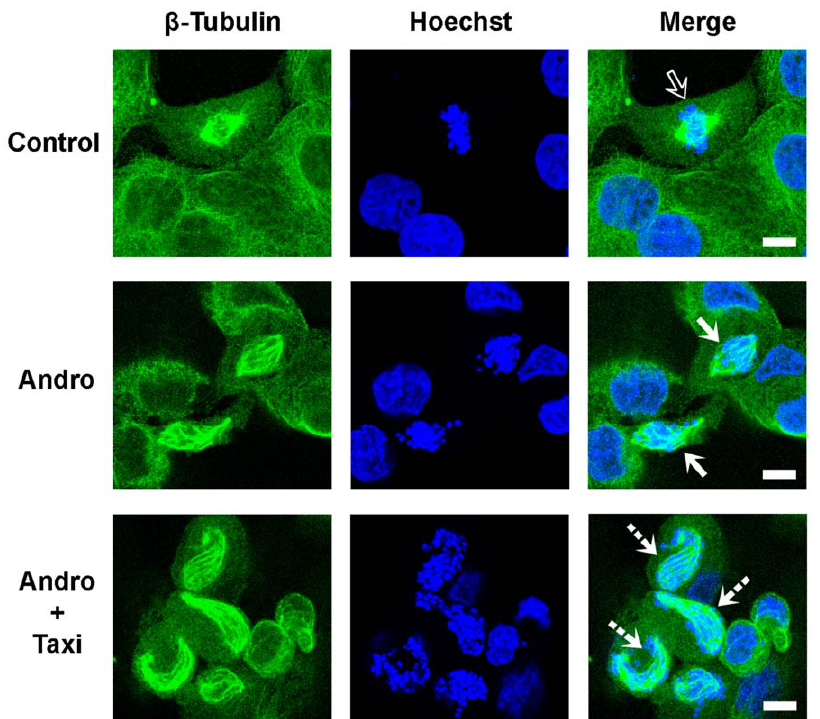
Figure 9. Immunofluorescence microscopic images of treating DU145 cells with Andro and Taxi on the spindle-chromosome configuration. The cells were treated with 20 m M of Andro in the presence and absence of 100 m M of Taxi for 24 h. The treated cells were fixed and immunostained with anti-tubulin antibody and FITC conjugated secondary antibody to visualize microtubules (green) and Hoechst 33342 to visualize chromosomes (blue). Representative images of spindle organization in the cells treated with vehicle control (hollow arrow), Andro alone (solid arrows) and combined Andro and Taxi (dashed arrows) are shown. Bar=10 m m.